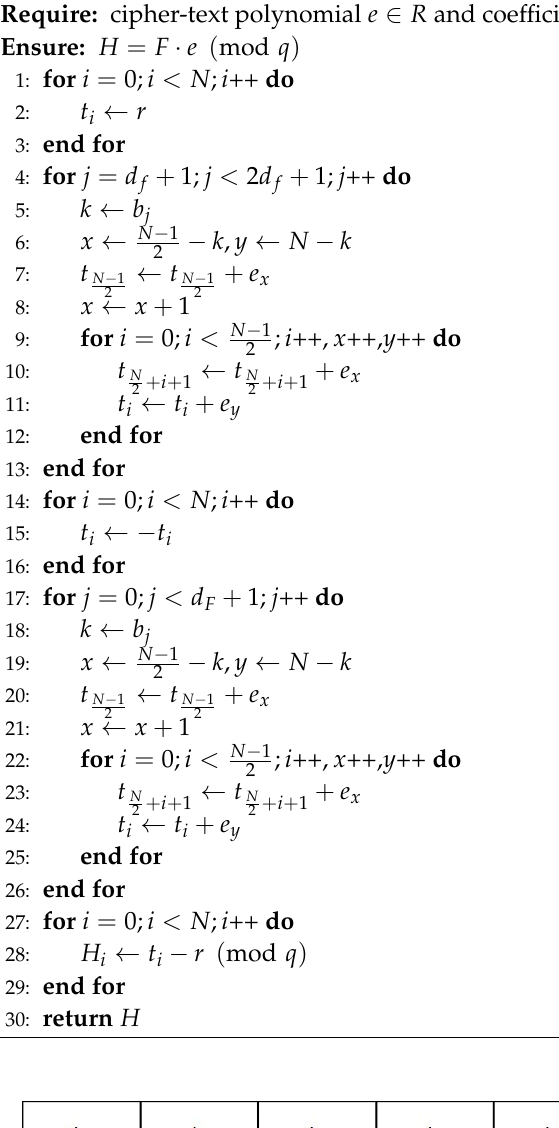
Algorithm 4 Countermeasure of NTRU Open Source